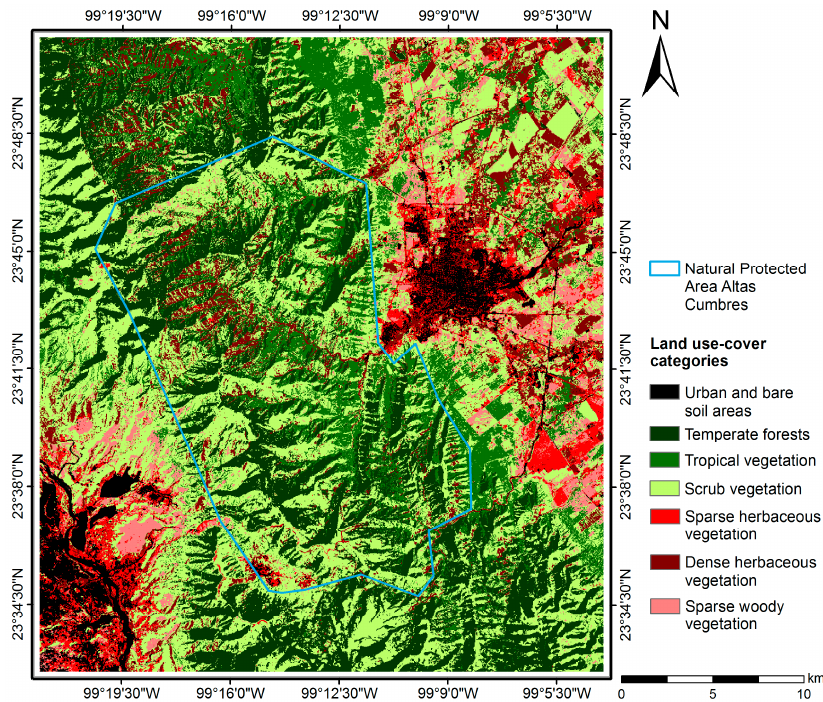
Figure A1. Land use-cover in 1973, Natural Protected Area Altas Cumbres and adjacent area. Victoria, Tamaulipas, Mexico.